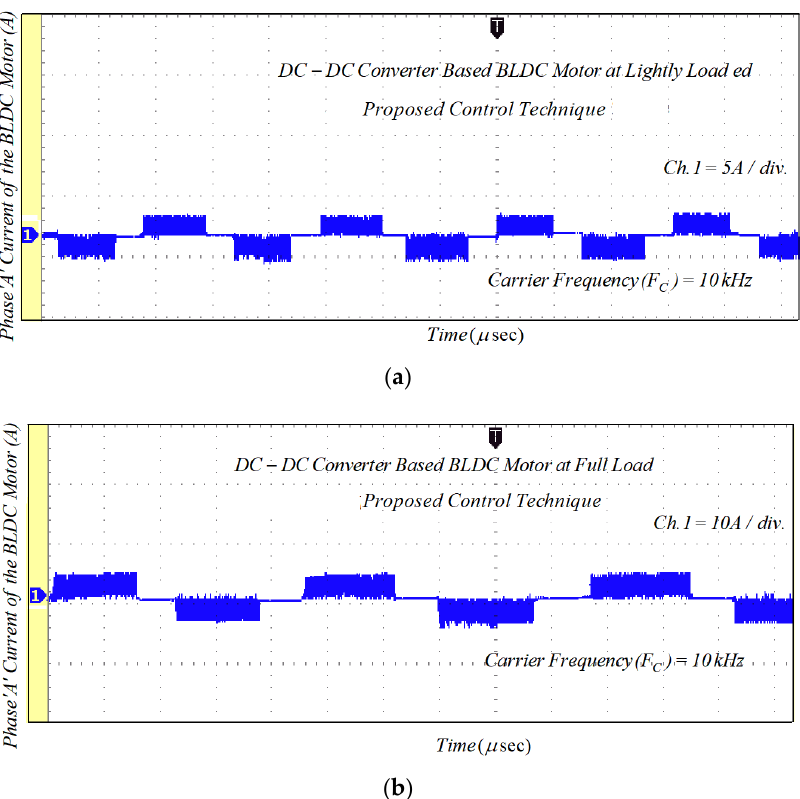
Figure 20. Experimental results of motor current with PWM ‐ MAC technique: ( a ) lightly loaded condition, 2 A/div.; and ( b ) full load, 5 A/div.